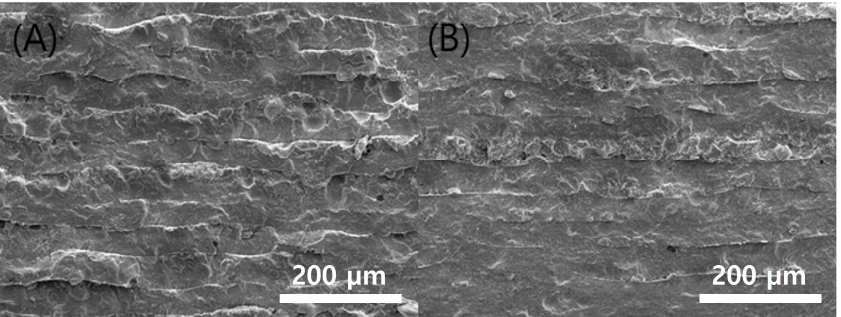
Figure 14. Cross-sectional SEM images green body specimens according to various curing times: ( A ) 0.8 s; ( B ) 1 s.